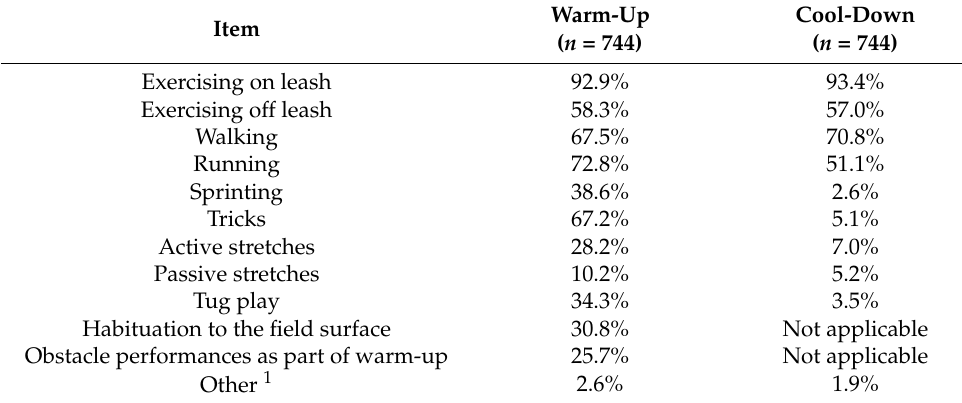
Table 5. Elements of usual warm-up and cool-down.